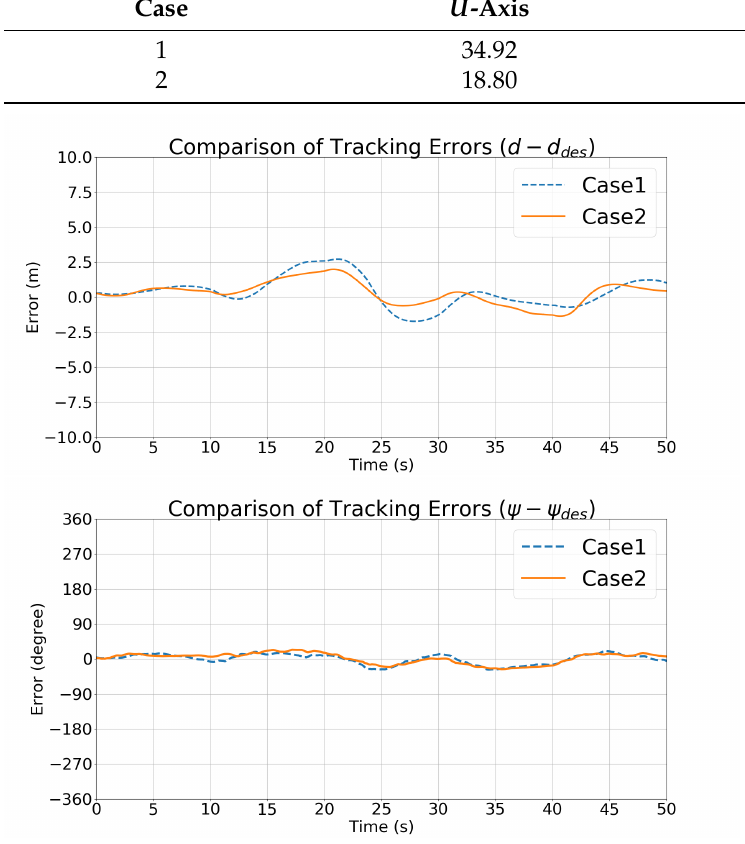
Figure 22. Simulation 3: comparisons of the state vector tracking errors.